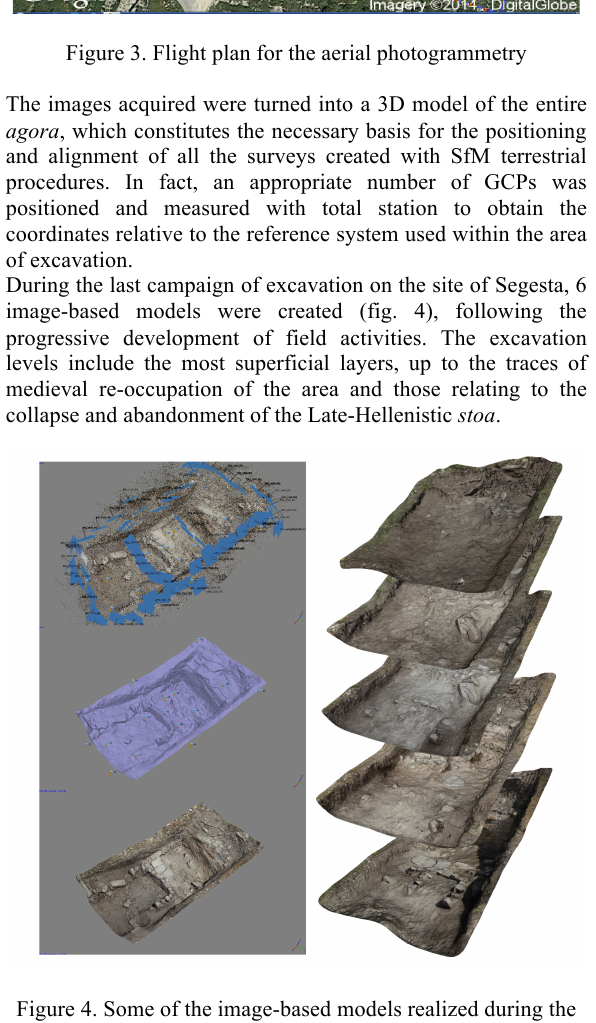
Figure 4. Some of the image-based models realized during the fieldwork